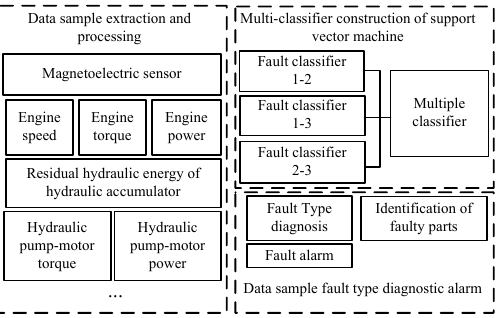
Figure 4. Structure diagram of the power performance fault alarm model of the hydraulic hybrid electric vehicle.